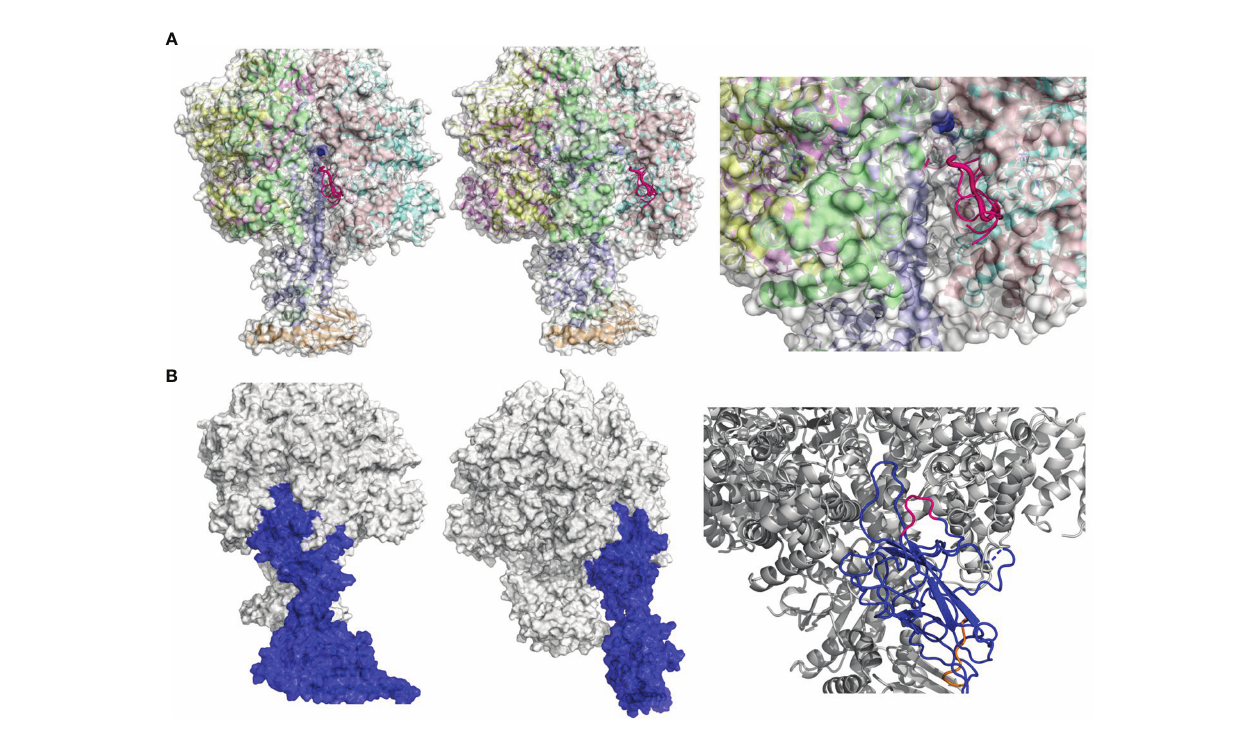
FIGURE 3 | Prediction of FlgE – ATP5B interacting mode by structural modeling. (A) Identi fi cation of potential binding site(s) on the surface of ATP synthase (PDB 1e79) for Pc-B and Pc-F peptides. Six or 8 of the top 10 best poses for B and F respectively were located onto a same groove on the beta subunit (chain E, 1e79_E) shown in front (left panel), side (middle), and close-up views (right). Only the peptides of B (in hot pink) are illustrated. The binding site involved residues 159 – 162 of chain E (B) The docking model of FlgE – ATP5B complex in front, side, and close-up views. FlgE is illustrated in blue and ATP5B in mixed color, while site B and site F are shown in hot pink and orange, respectively, in the close-up view